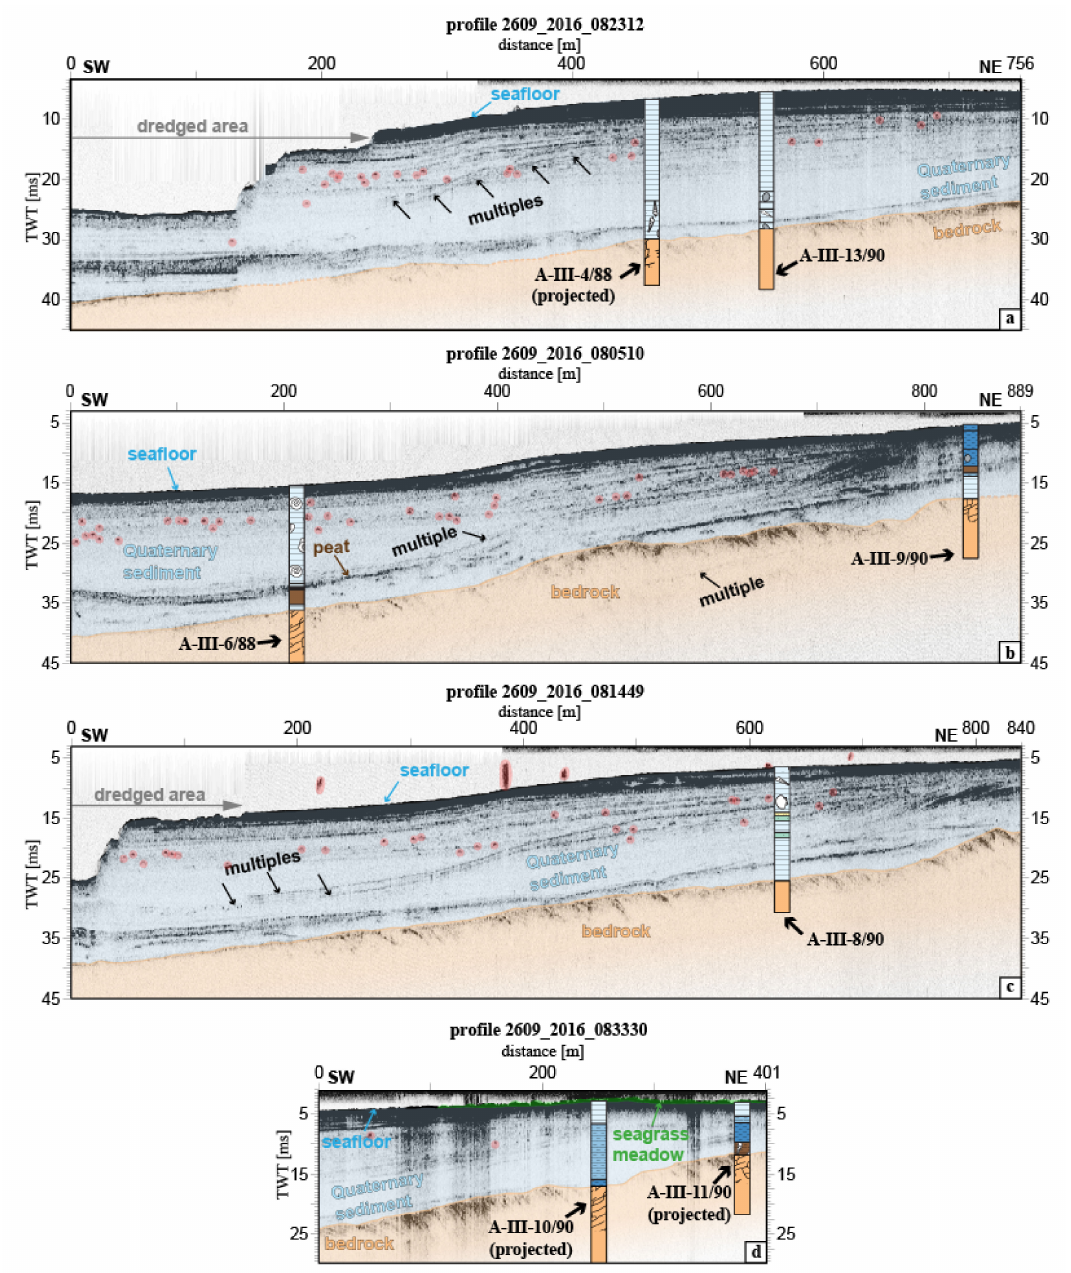
Figure 5. Borehole logs determined from geotechnical reports (see Section